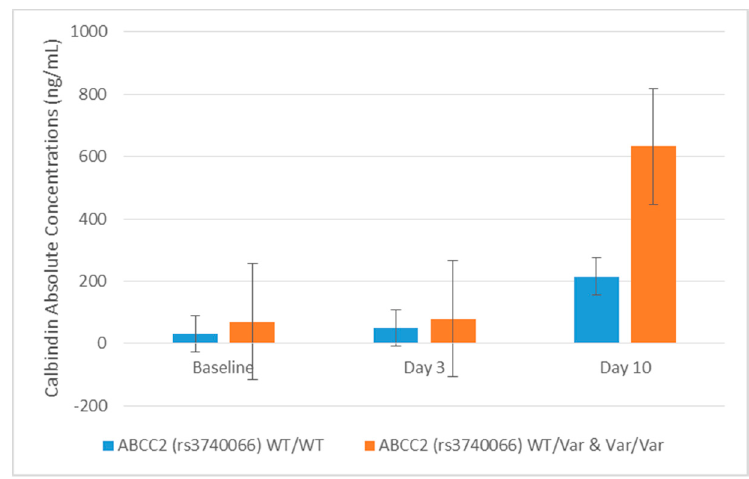
Figure 3. Comparison of calbindin absolute concentrations to ABCC2 (rs3740066) genotype in ambulatory cancer patients prescribed cisplatin. Absolute concentrations of calbindin were elevated in patients with the variant allele at all time points; statistically significant at baseline ( p = 0.047), Day 3 ( p = 0.02), and Day 10 ( p = 0.02) versus homozygous wildtype patients. Error bars represent standard deviations. Abbreviations: Wild type: WT, Variant: Var.